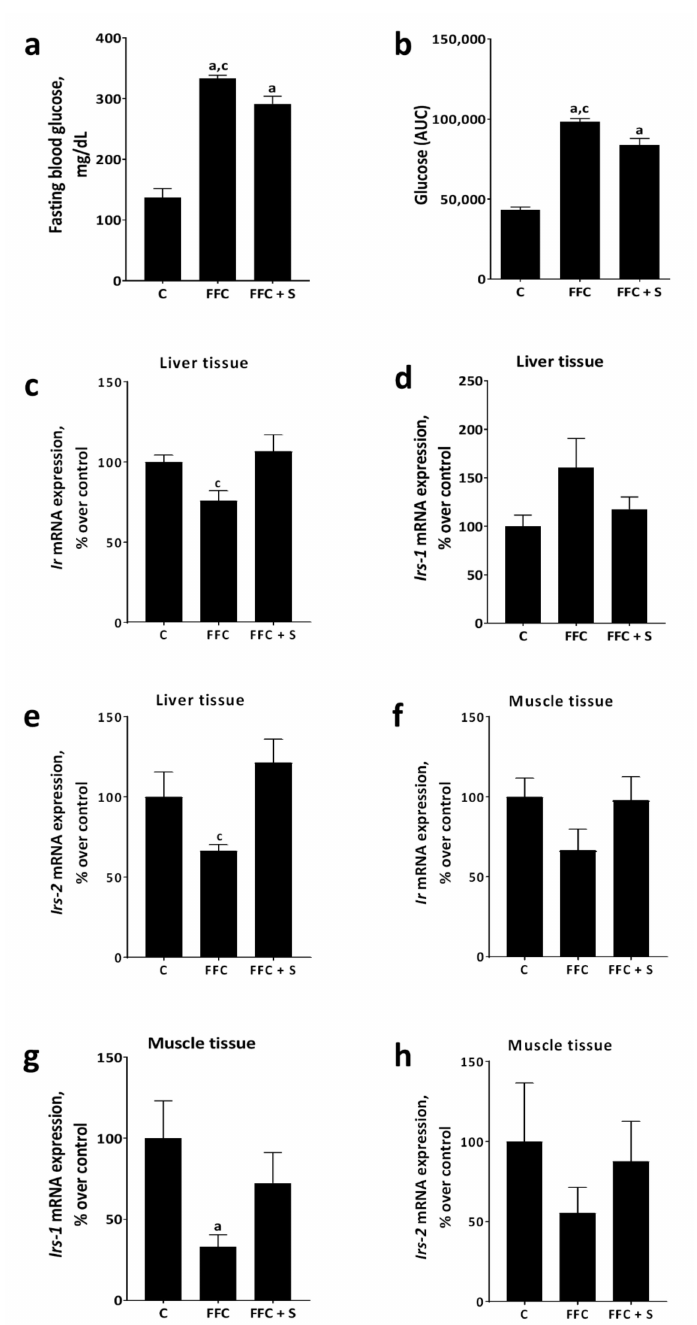
Figure 2. Effect of fortifying the fat-, fructose-, and cholesterol-rich diet with 4E% soybean oil on markers of glucose metabolism in mice. ( a ) Fasting blood glucose levels and ( b ) area under the curve (AUC) of glucose levels during the glucose tolerance test. Expression of ( c ) insulin receptor ( Ir ), ( d ) insulin receptor substrate-1 ( Irs-1 ), and ( e ) insulin receptor substrate-2 ( Irs-2 ) mRNA in the liver tissue. Expression of ( f ) Ir , ( g ) Irs-1 , and ( h ) Irs-2 mRNA in muscle tissue. Data are presented as means ± SEM, n = 6–8 mice per group with n = 6–8 livers or muscle specimens being analyzed per group and measurements. Data of AUC, Irs-1 and Irs-2 in liver tissue, and Irs-1 in muscle tissue were log-transformed before statistical analysis. C: control diet; FFC: fat-, fructose-, and cholesterol-rich diet; FFC + S: fat-, fructose-, and cholesterol-rich diet supplemented with soybean oil. a p ≤ 0.05 compared with mice fed the C-diet. c p ≤ 0.05 compared with mice fed the FFC +